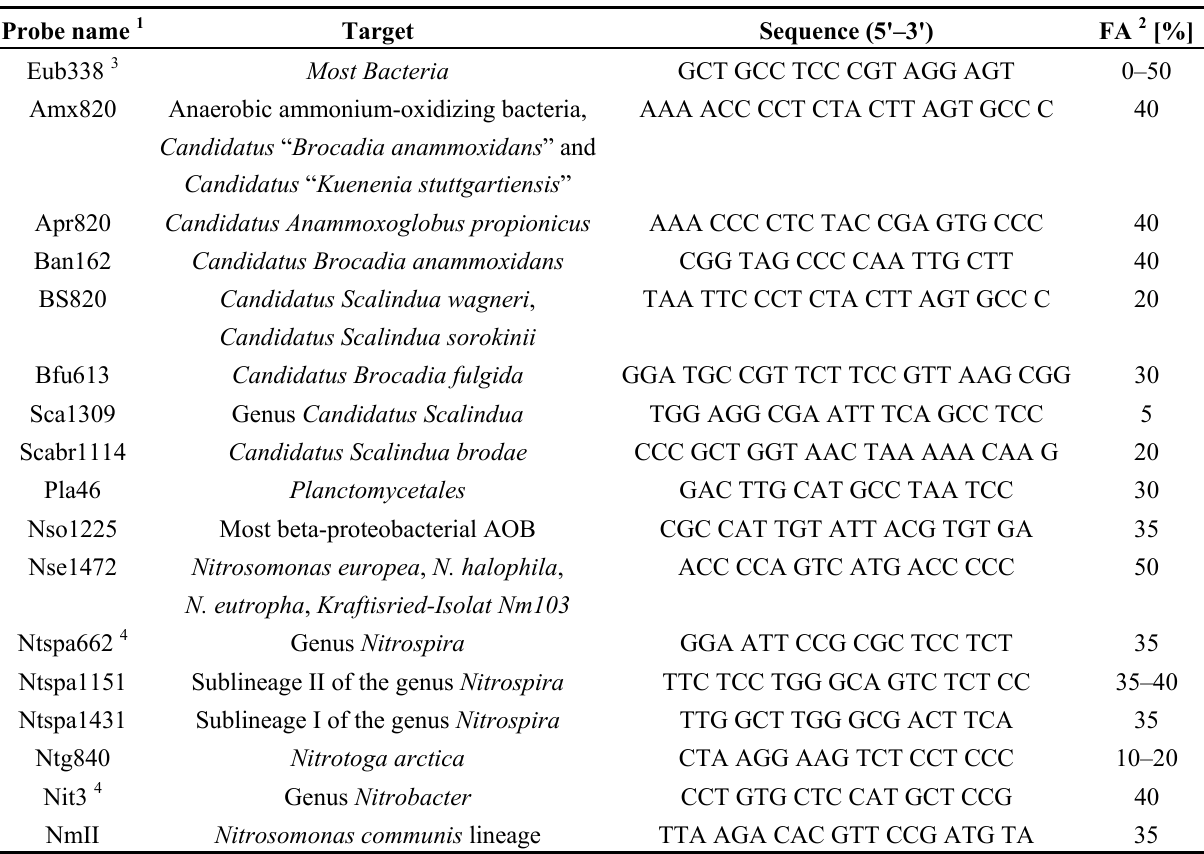
Table S2. Oligonucleotide probes used for fluorescence in situ hybridization (FISH) in this